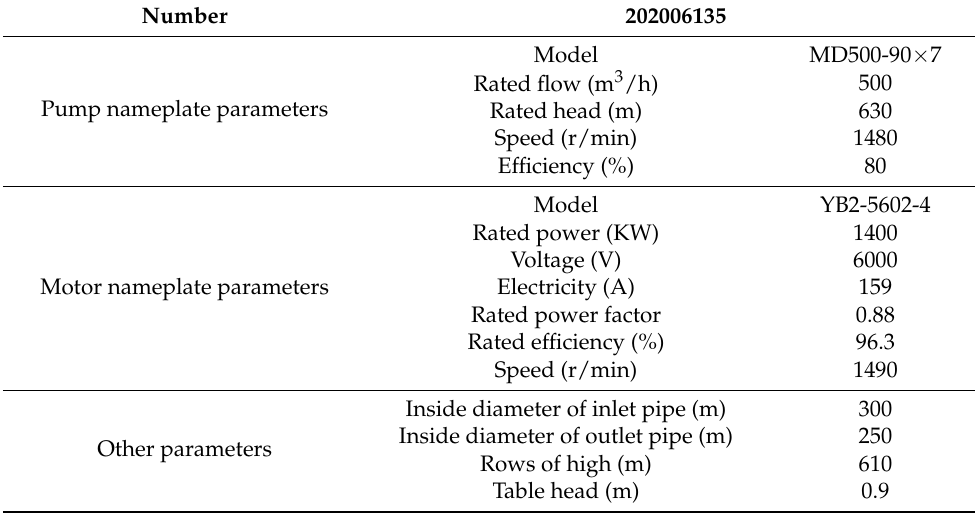
Table 1. The main technical parameters of MD500-90 × 7 self-balancing multistage pump.